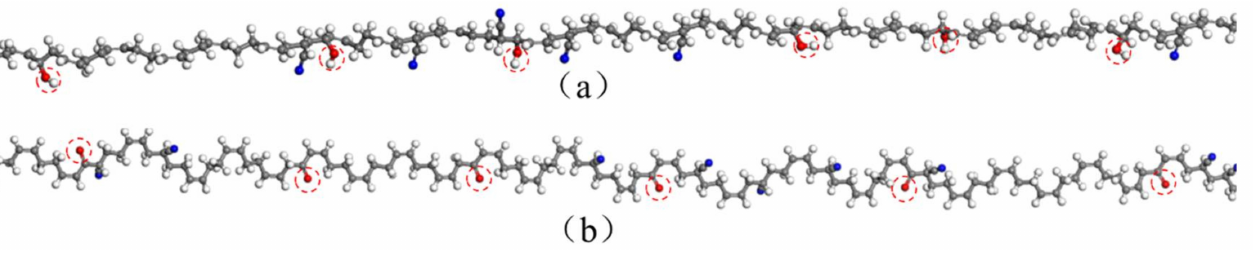
Figure 1. The unaged nitrile rubber molecular chain.